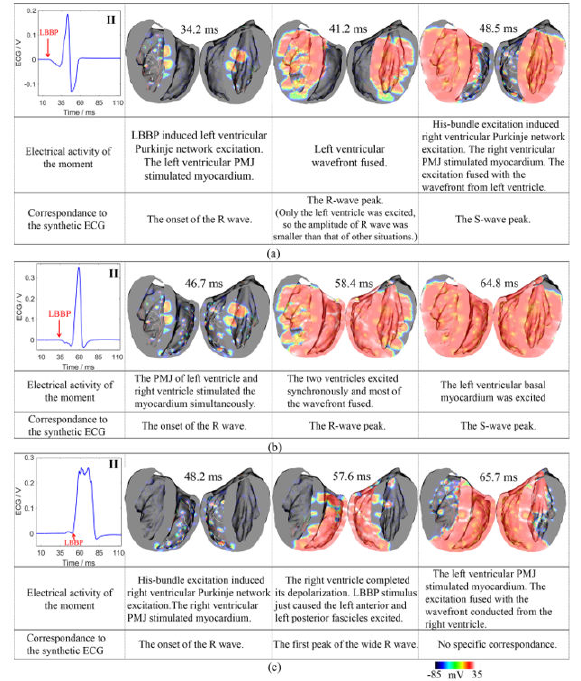
Figure 6. Synthetic QRS complex (lead II), activation sequences, and electrical activities’ analyses of LBBP simulations. ( a ) LBBP stimulus started at 18 ms. ( b ) LBBP stimulus started at 34 ms. ( c ) LBBP stimulus started at 50 ms. LBBP: left bundle branch pacing. PMJ: Purkinje-muscle